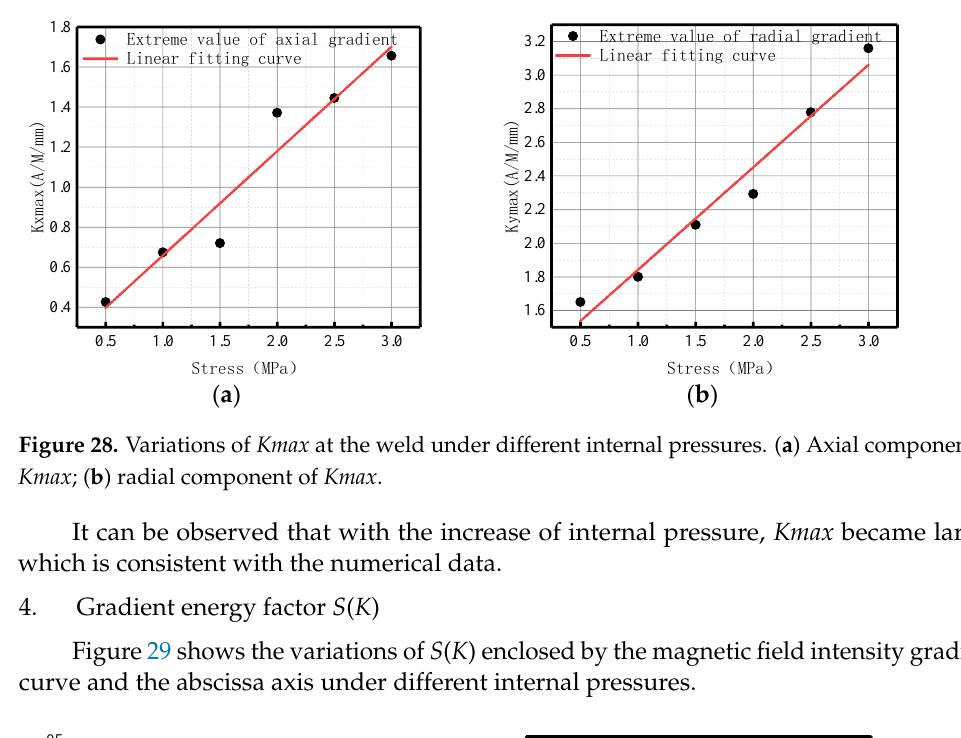
19 of 28 Figure 26. Peak value variations with internal pressure. ( a ) Peak values of the axial component; ( b ) peak-to-peak values of the radial component. It can be observed from the above-illustrated figure that the peak value of the axial component and the peak-to-peak value of the radial component increased linearly with the elevation of internal pressure. 2. Magnetic field strength gradient K The variations of the magnetic field strength gradient K under different internal pres- sures are shown in Figure 27. ( a ) ( b ) Figure 27. Variations of the magnetic field strength gradient K at the weld under different internal pressures. ( a ) The axial gradient component Kx; ( b ) the radial gradient component Ky.